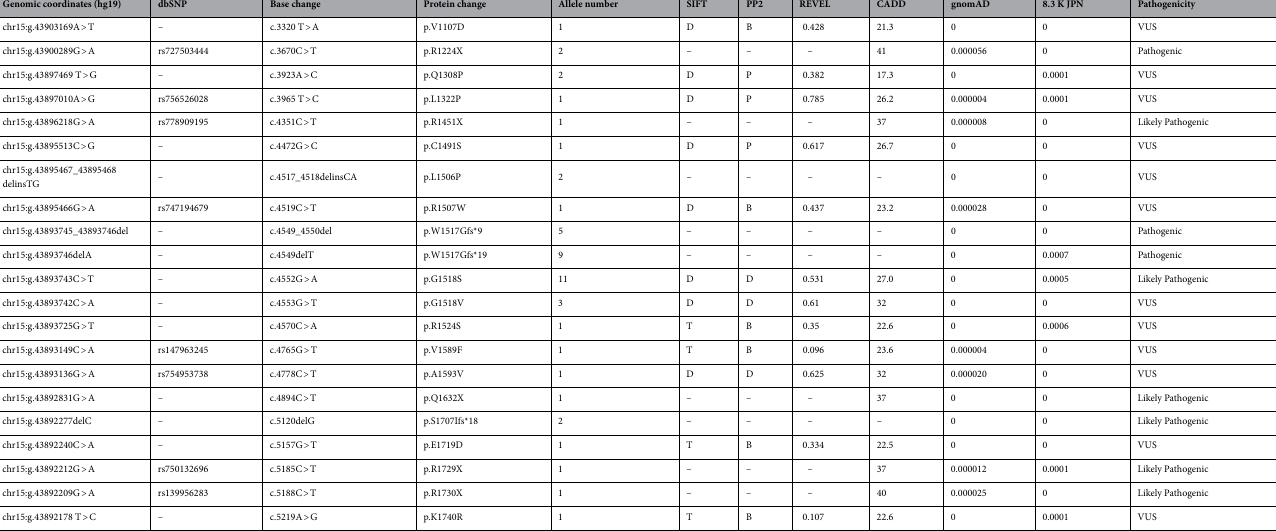
Table 1. SNVs or small insertion/deletion variants identified in this study. gnomAD: allele frequency in the gnomAD database (https:// gnomad. broad insti tute. org), 8.3 K JPN: allele frequency in the 8380 Japanese control population (https:// jmorp. megab ank. tohoku. ac. jp/ 202109/), PP2: PolyPhen2, T: tolerated, B: benign, D: deleterious or probably damaging P: possibly damaging, VUS: variant of uncertain significance. All variants are indicated on